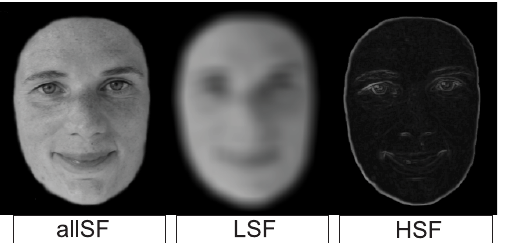
Figure 2. Example of a face with all spatial frequency information (allSF), only low spatial frequency information (LSF), or only high spatial frequency information (HSF). Note that the prints underestimate the contrasts used in the current experiment, especially for the LSF and HSF pictures.